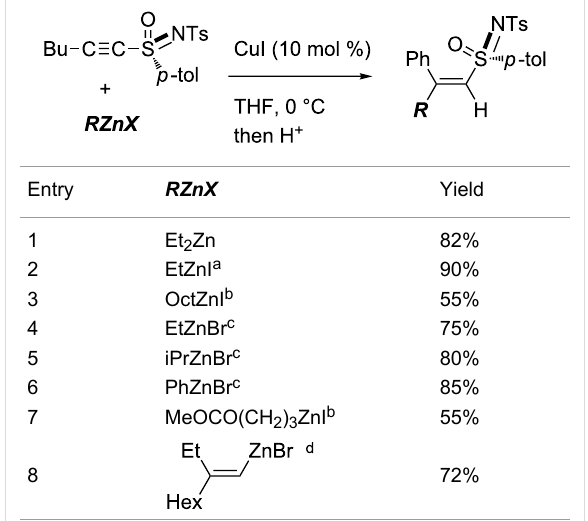
Table 1: Copper-catalyzed carbozincation of alkynyl